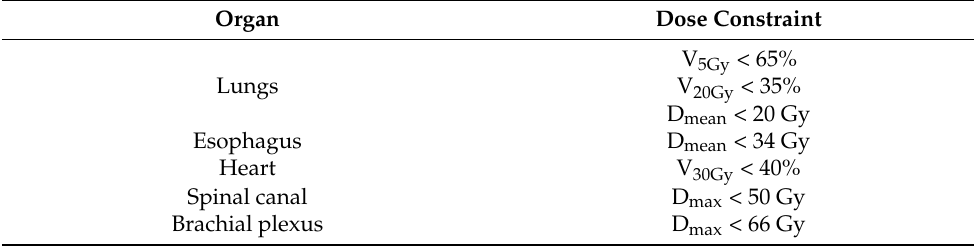
Table A1. Planning dose constraints for organs at